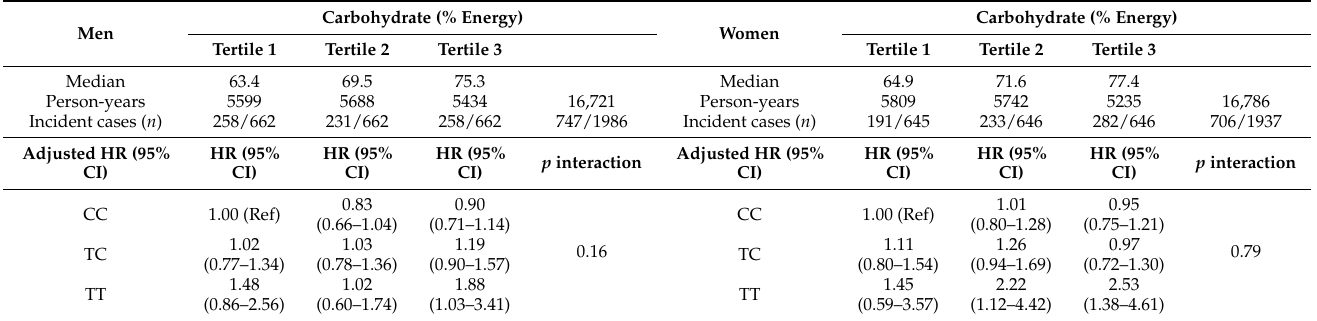
Table 7. Adjusted hazard ratios (HRs) and 95% confidence intervals (CIs) of metabolic syndrome incidence depending on the genotype of SLC35F3 rs10910387 by carbohydrate